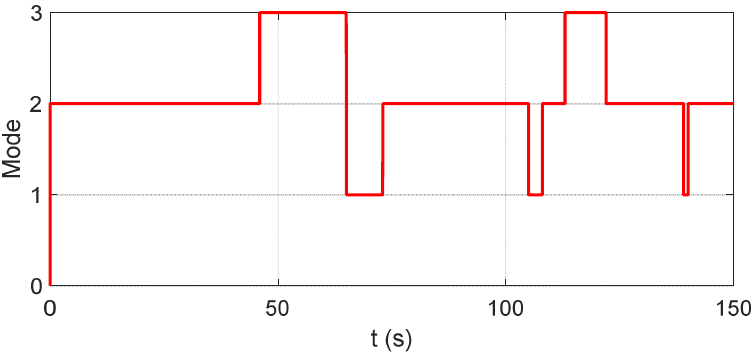
Figure 12. Designed vehicle speed profile.